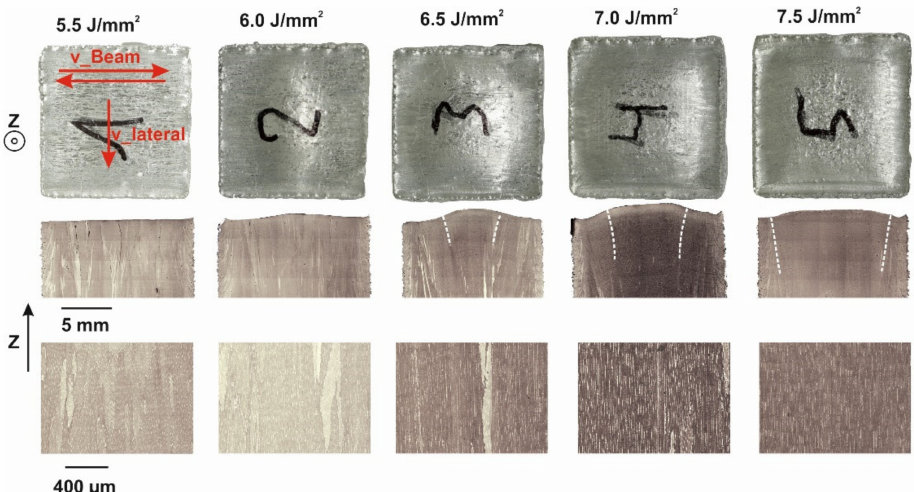
Figure 3. Influence of the energy input at constant v_lateral. Top: Surface topography. Middle: Light microscopic length sections showing the microstructure and bulges at the surface. The dashed white line indicates the SX region. Bottom: Magnification of the microstructure. (v_Beam: 400 mm/s, hatch distance: 100 µ m, v_lateral: 2.67